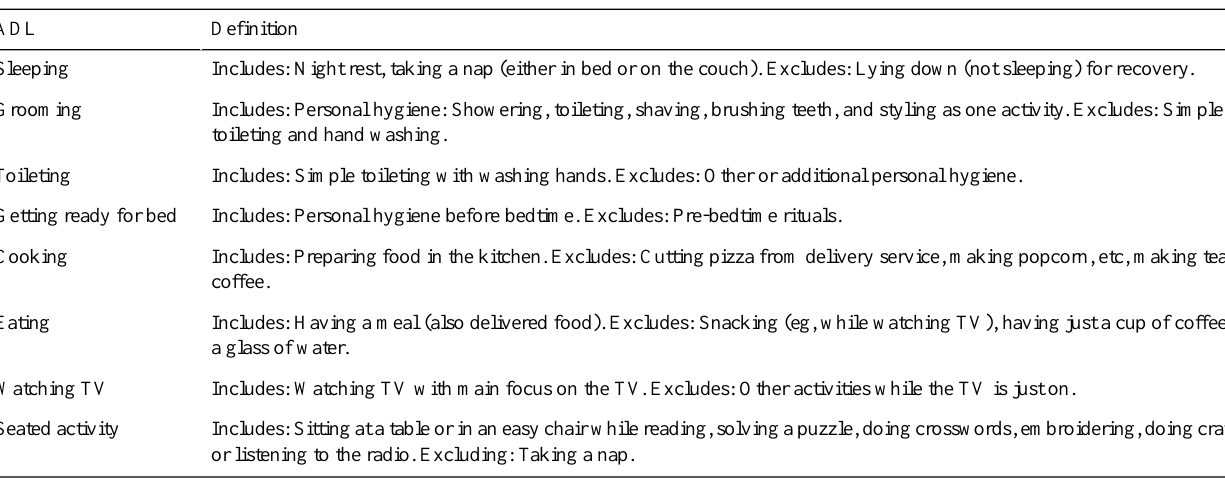
Table 1. The eight ADL in detail, with